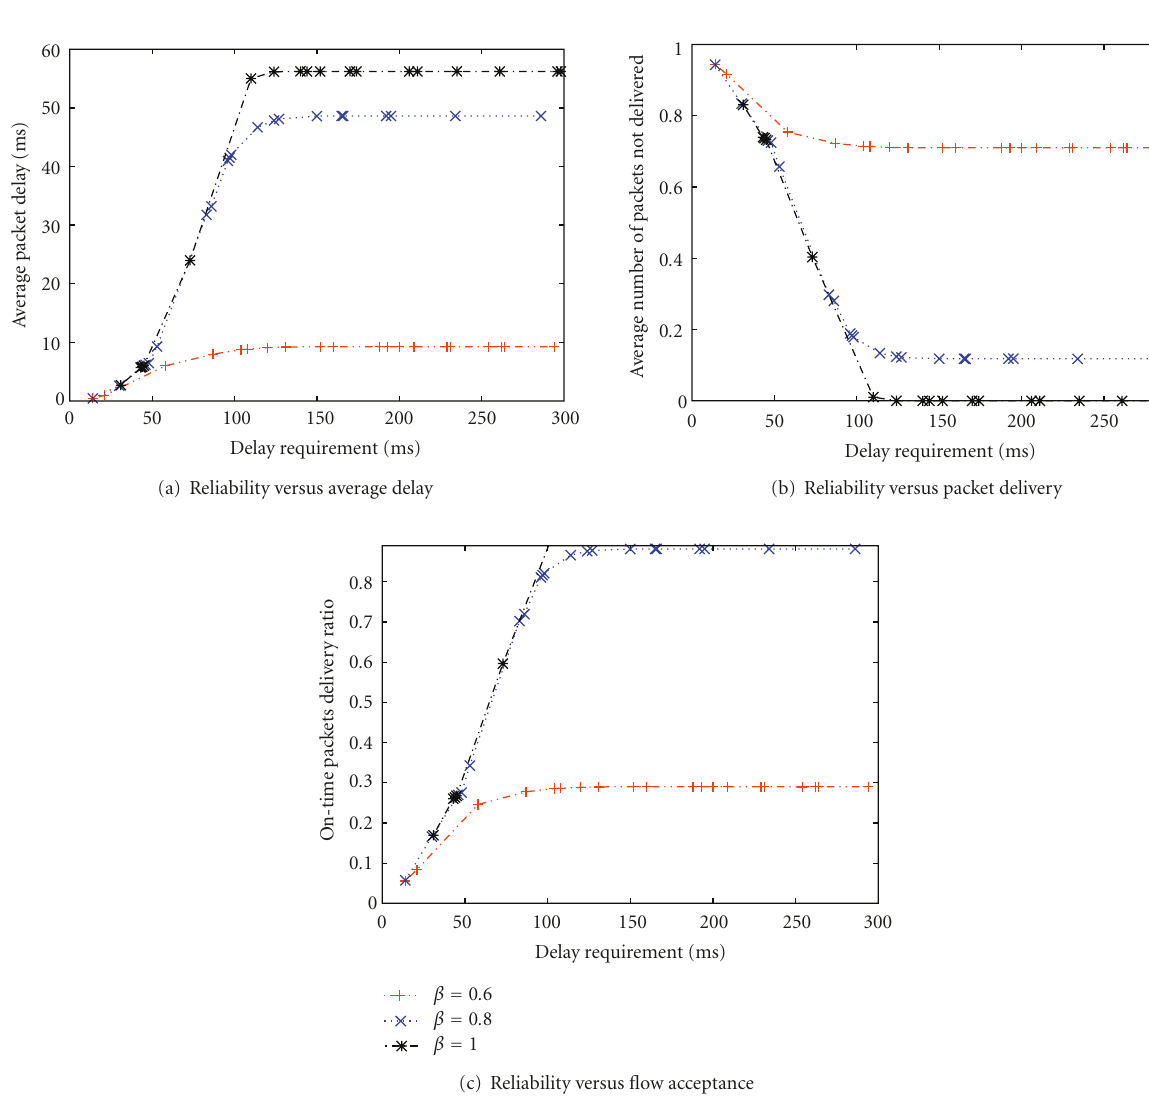
Figure 7: The impact of reliability on TE